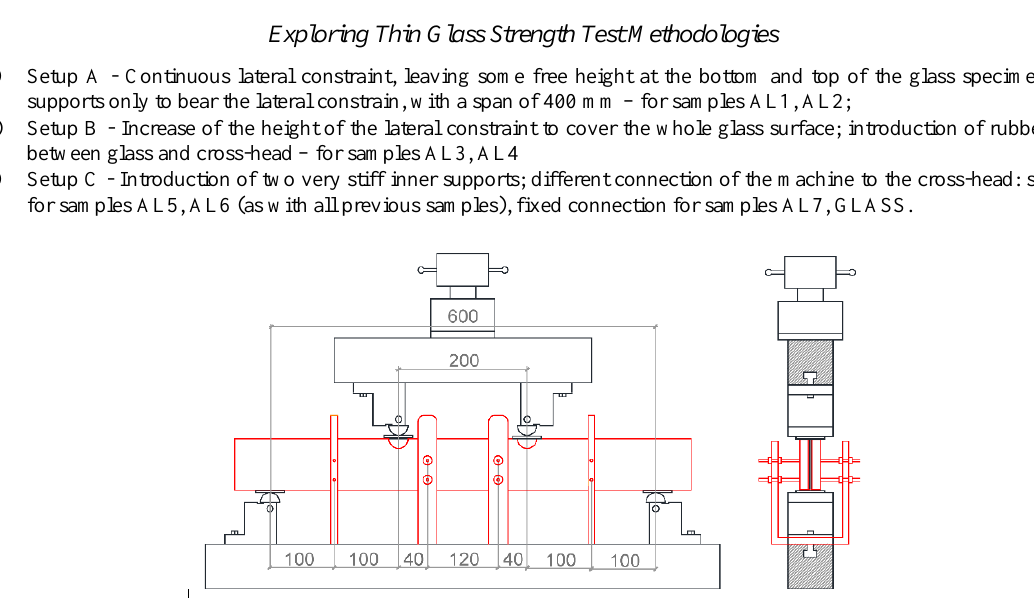
Fig. 1 In-plane four-point bending final setup, front (left) and side (right) views, with focus on dimensions and lateral constraint (red)